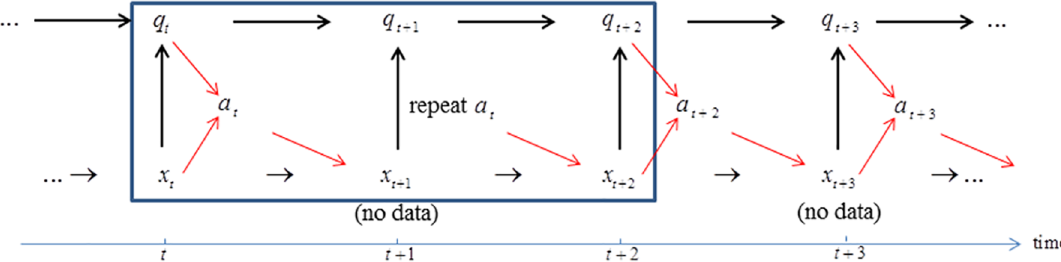
Fig 5. Scenario 4: Biennial decision making and biennial monitoring. Actions a t and a t +1 = a t are selectedbasedon system state x t and model state q t . Realizedsystem state x t +2 is identifiedthrough monitoringin year t +2. Model state q t is updatedto q t +2 with Bayes’ Theorem. This sequence,with the same action chosen in successiveyears, is repeatedover the remainderof the time frame.